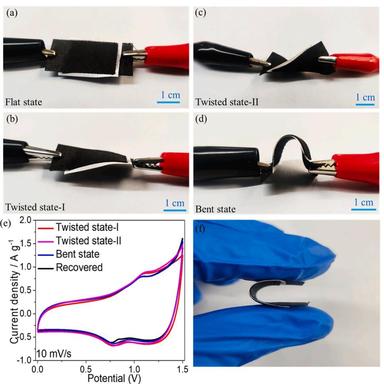
Images of device (a) flat state, (b) twisted state-I, (c) twisted state-II, (d) bending state, (e) CV curves of the f-Co-O-NSs@CFC||AC at a scan rate of 10 mV/s for all indicated states and (f) optical image of the device in the bending state.